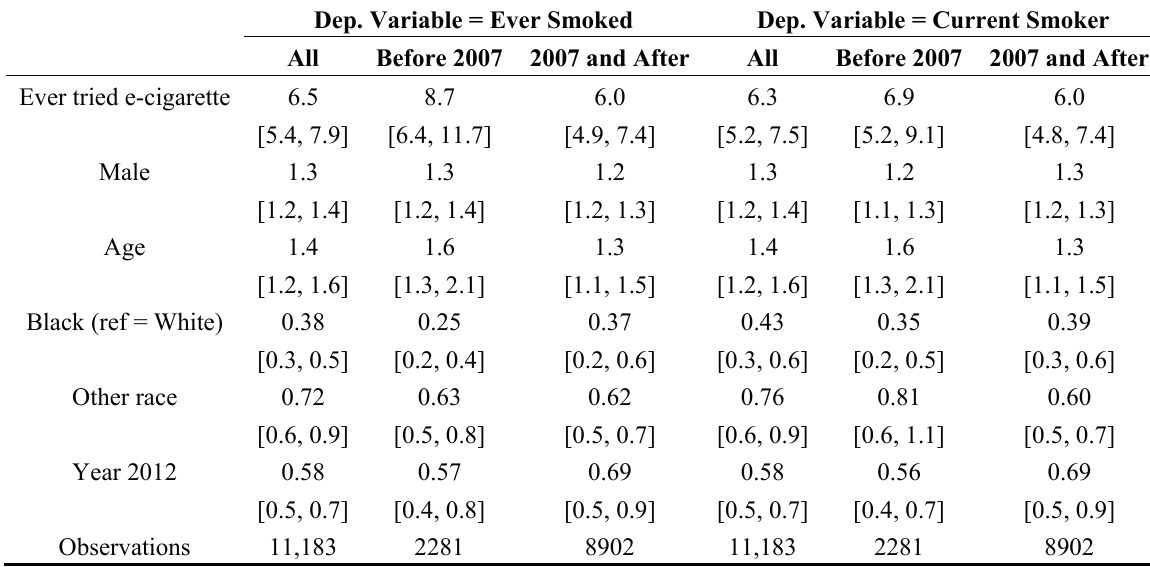
Table 5. Association of smoking and e-cigarette ever trying, by time of first trying a cigarette: before 2007 vs. later (ORs and 95%